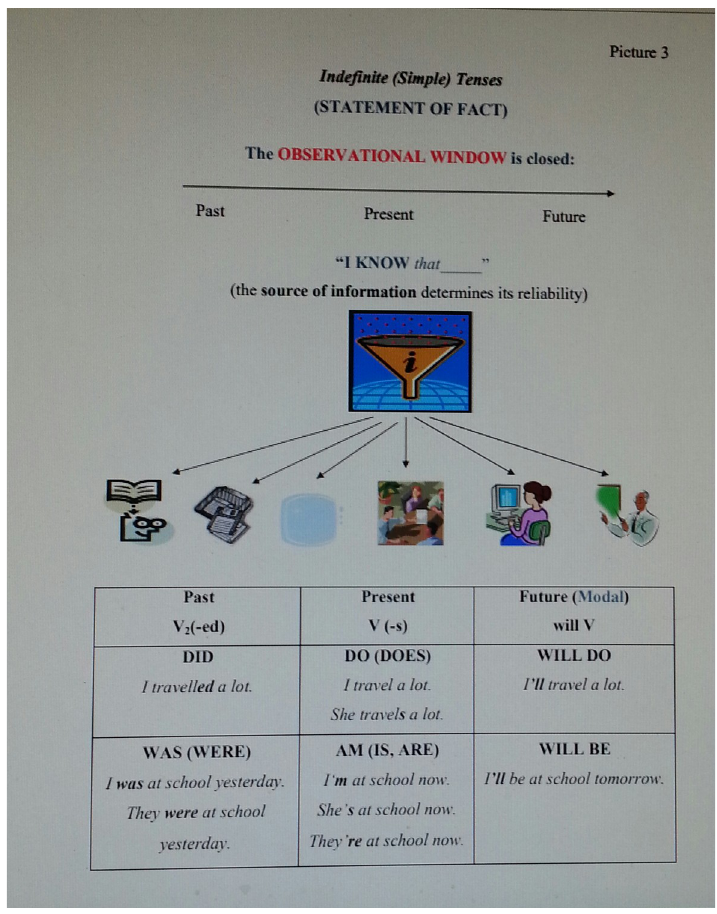
Figure 3 - Indefinite (Simple) Aspect (visual